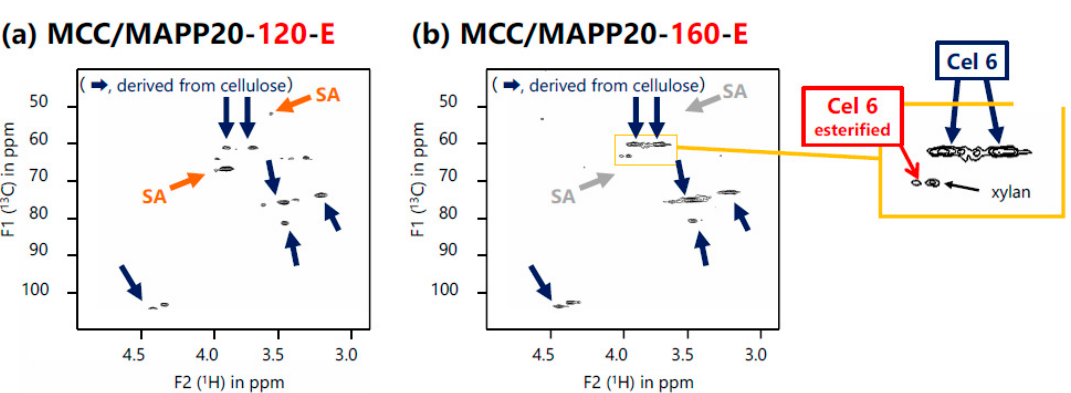
Figure 6. HSQC spectra of ( a ) MCC/MAPP20-120-E and ( b ) MCC/MAPP20-160-E immersed in DMSO- d 6 /pyridine- d 5 (4/1, v / v ).